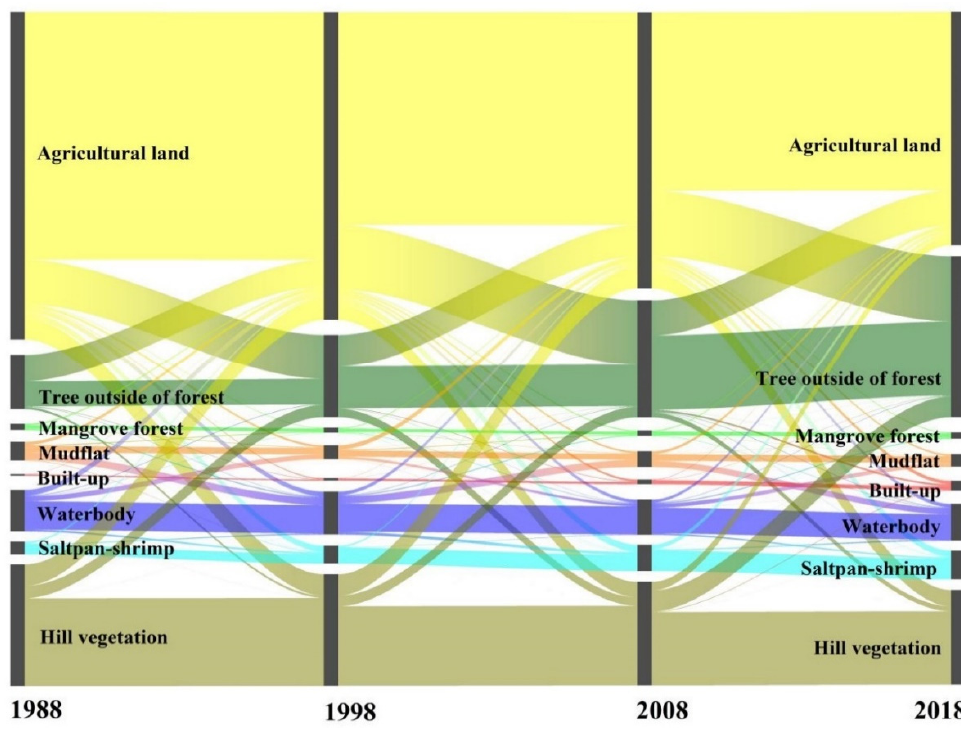
Figure 4. LULC transformation in the eastern coastal zone between 1988 and